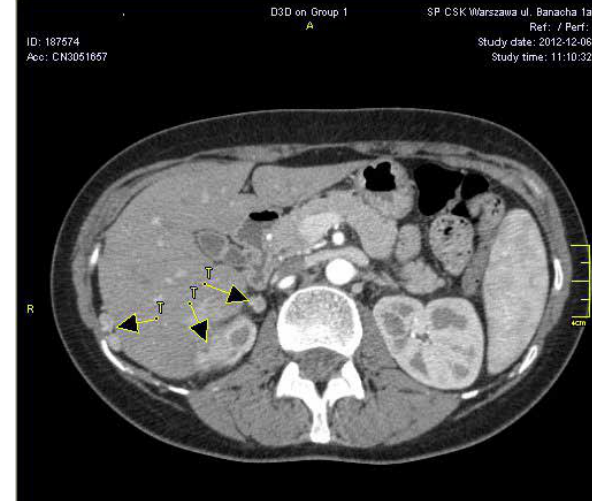
Figure 2: CT scan from 2012. Numerous nodules in sub hepatic region and in the post-operative area.